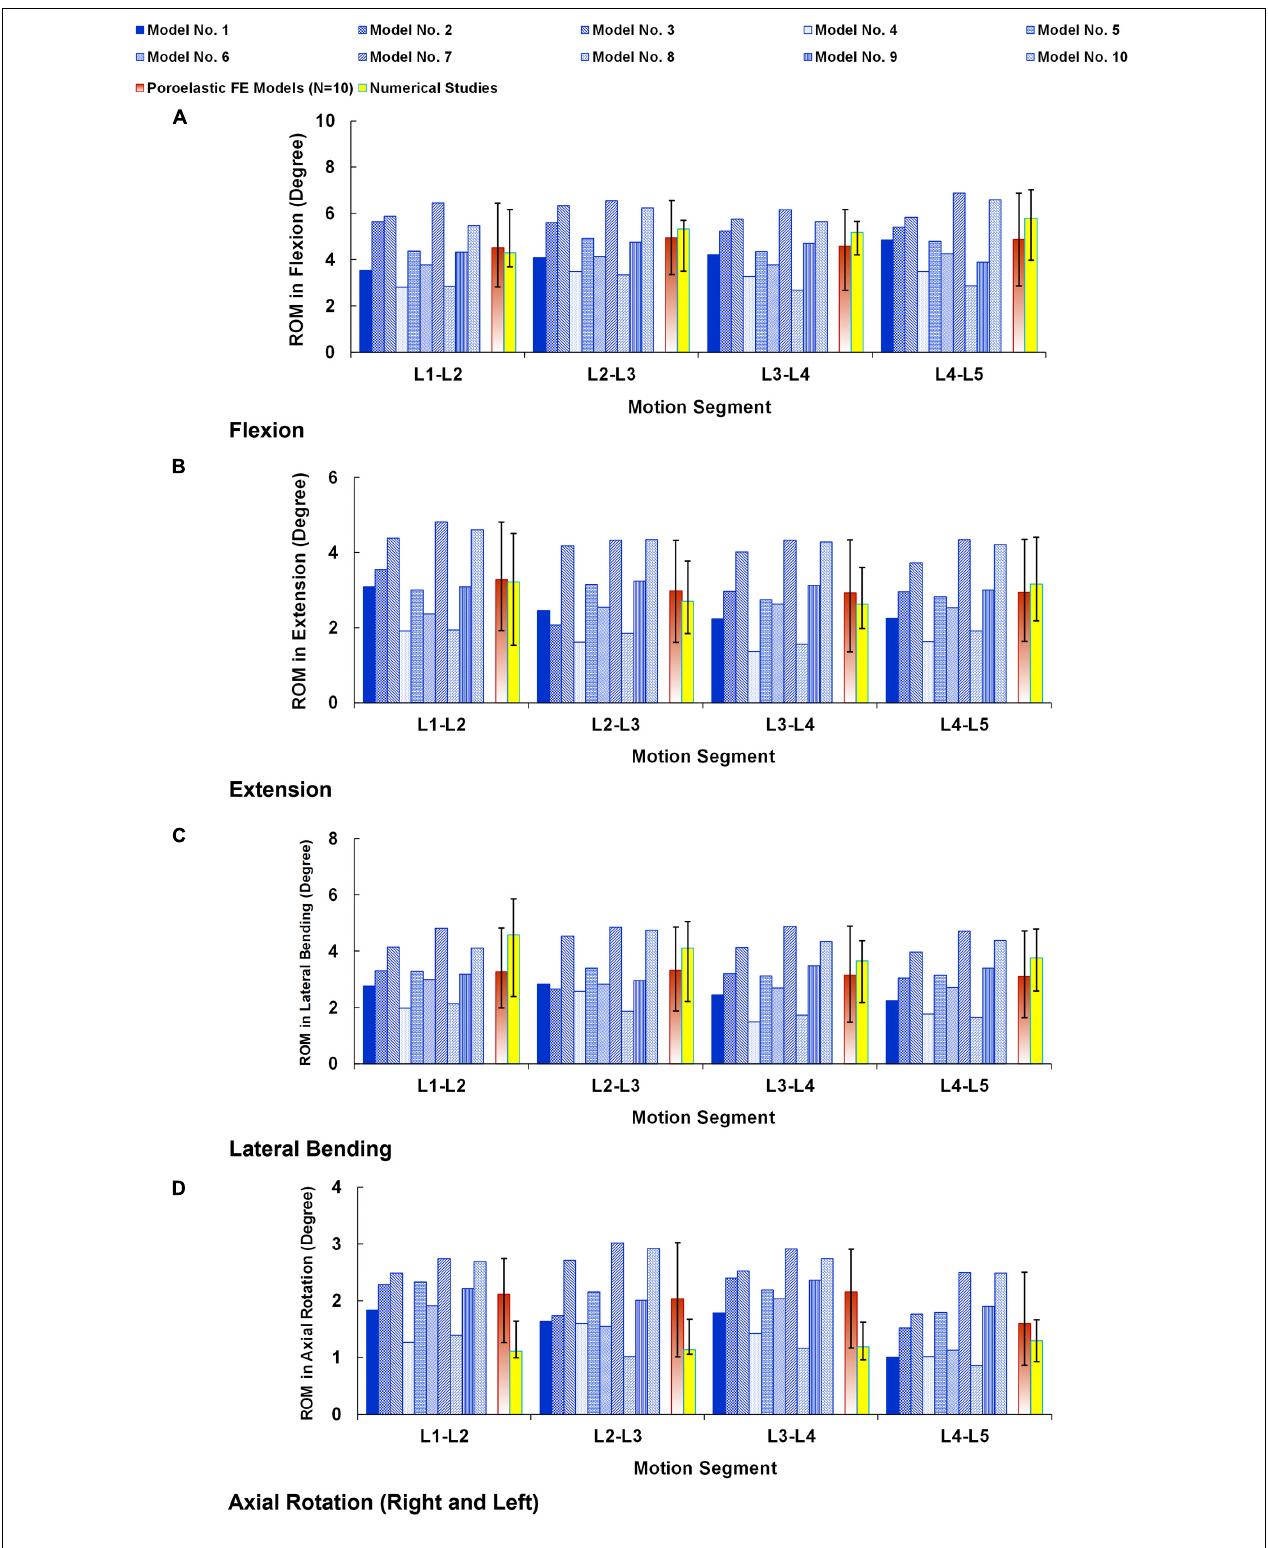
FIGURE 4 | Intersegmental range of motions (ROMs) for preoperative FE models compared with the numerical studies (Dreischarf et al., 2014) in (A) flexion, (B) extension, (C) lateral bending, and (D) axial rotation. The reported ROMs in lateral bending and axial rotation are the average in the left and right directions. The error bars indicate the ranges of the